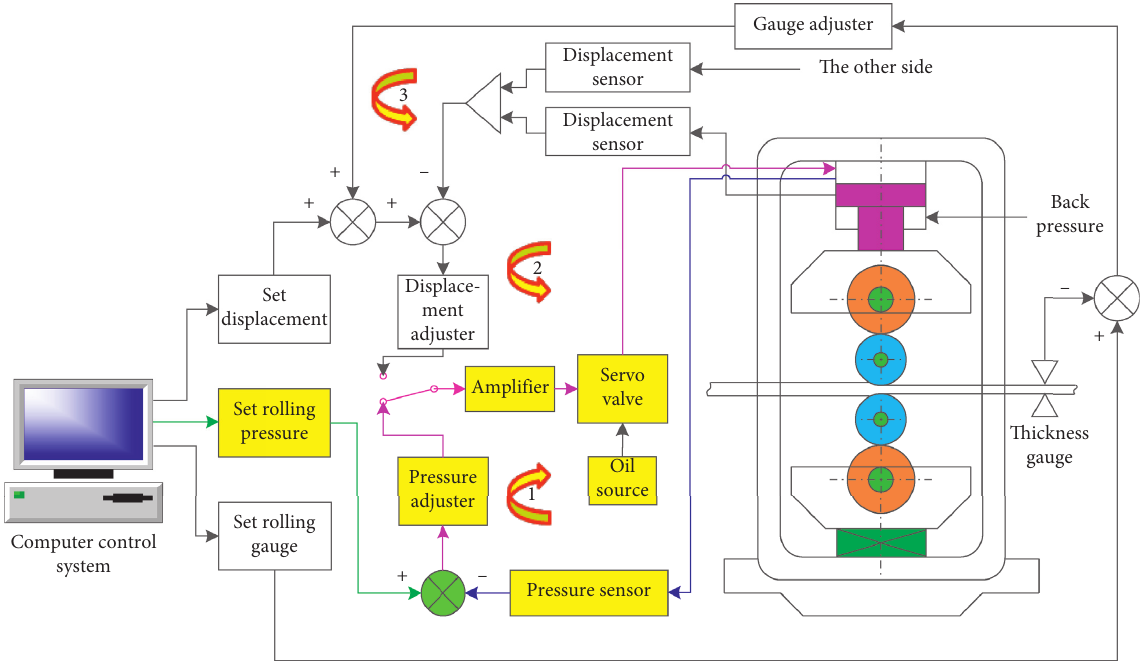
Figure 2: Function schematic of HAGC system.